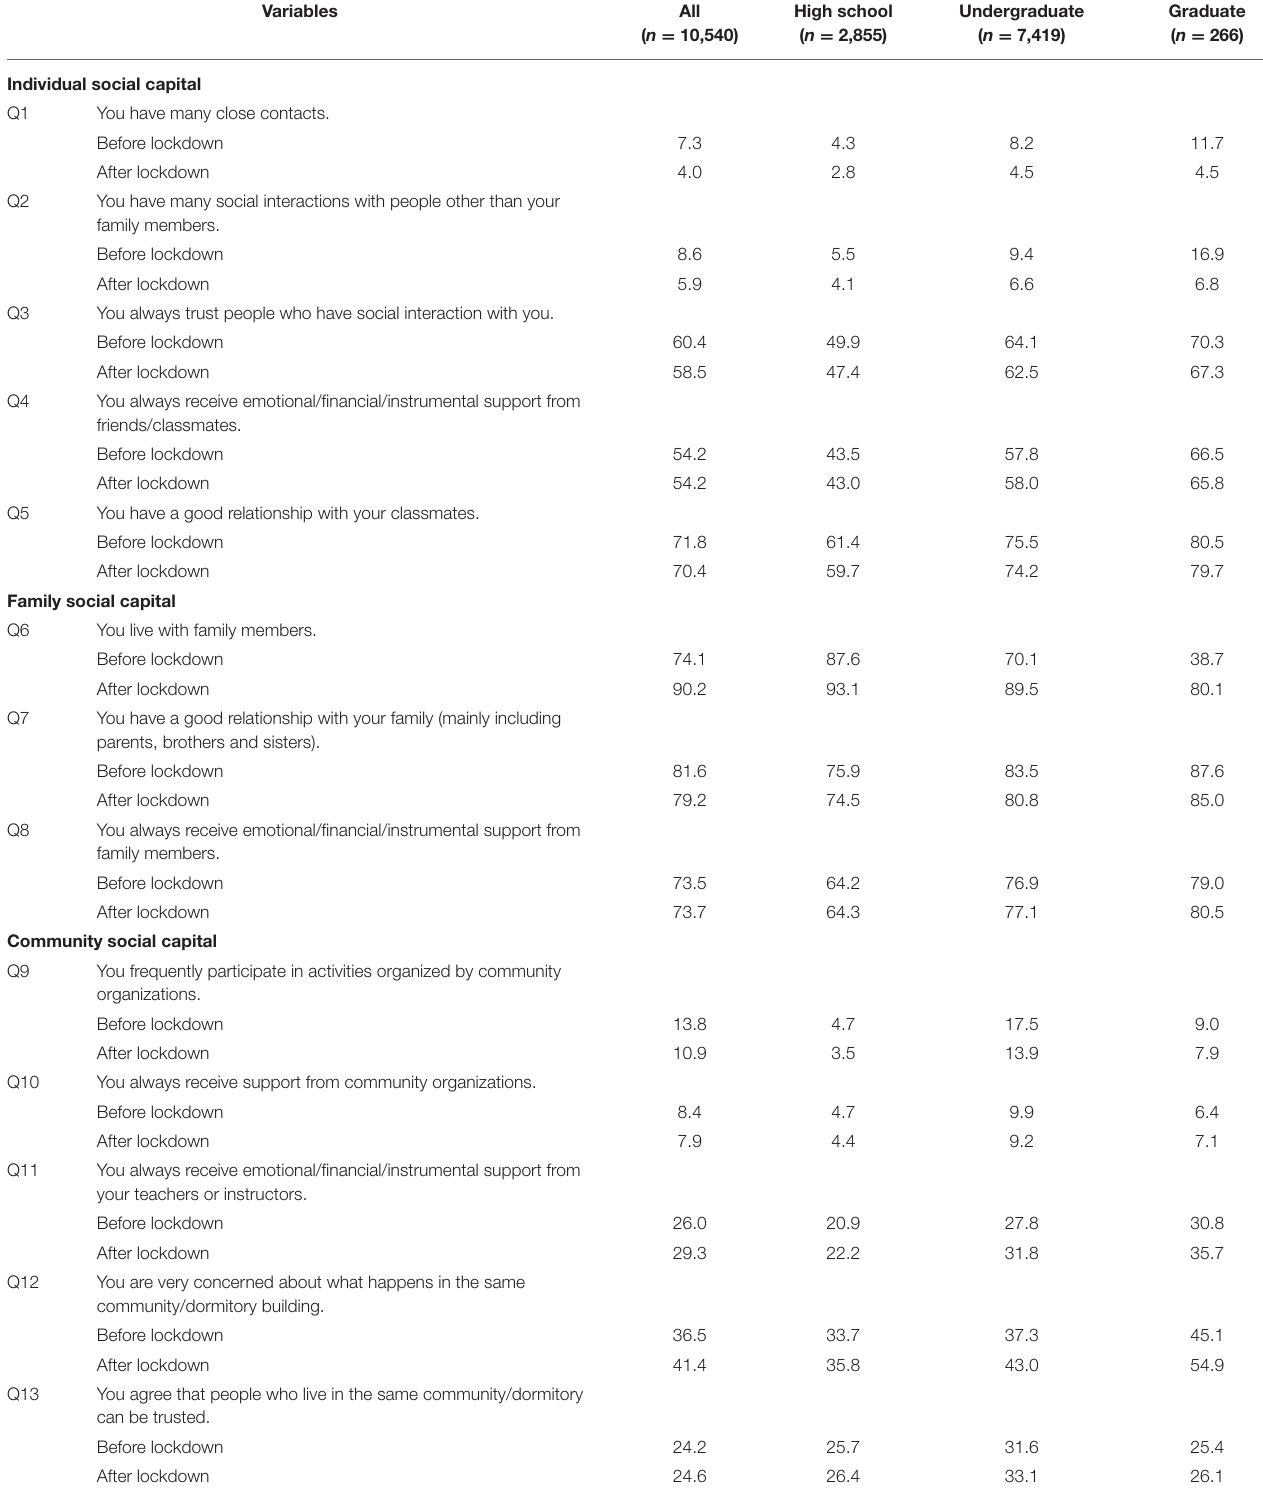
TABLE 1 | The percentages of the participating Chinese youths who (strongly) agreed each survey question of social capital before and after the COVID-19 lockdown in the COVID-19 Impact on Lifestyle Change Survey (COINLICS). Variables All